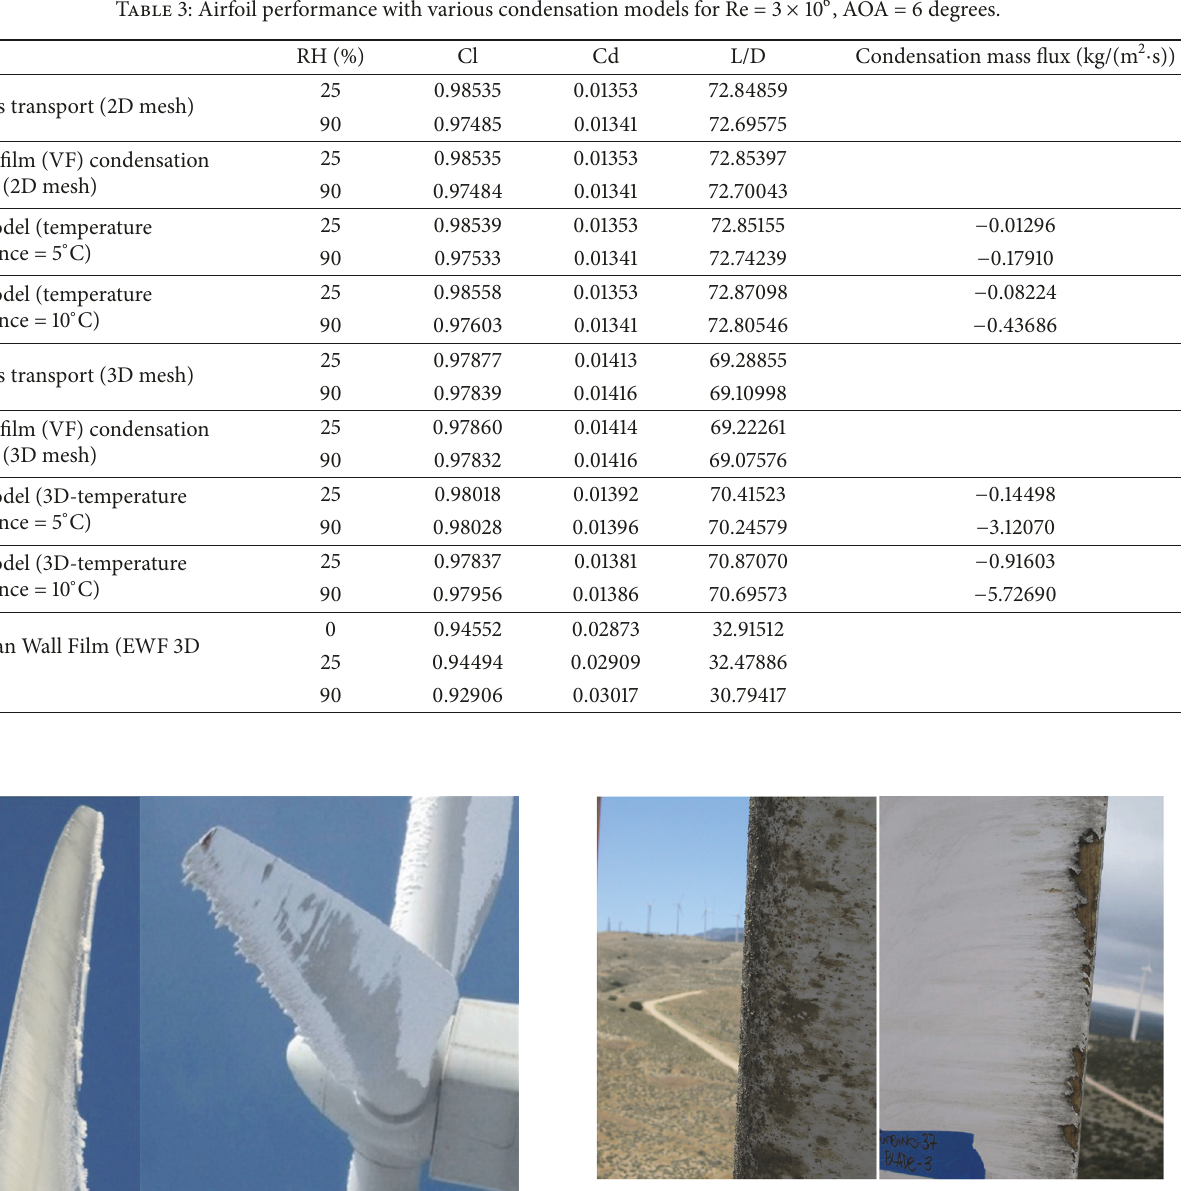
Figure 5: Blade contamination and erosion [15,